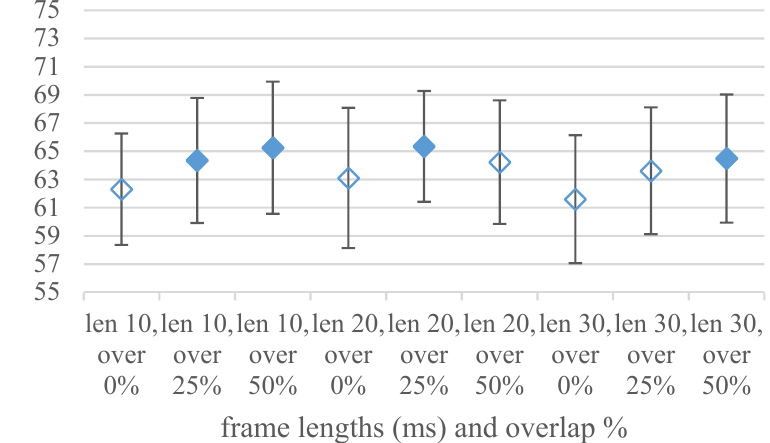
Figure 3. Averaged accuracies and standard deviations for 10, 20, and 30 ms frame lengths (len) with 0, 25, and 50% overlaps (over) and 8 kHz frequency range. Filled marks show equally performing settings.